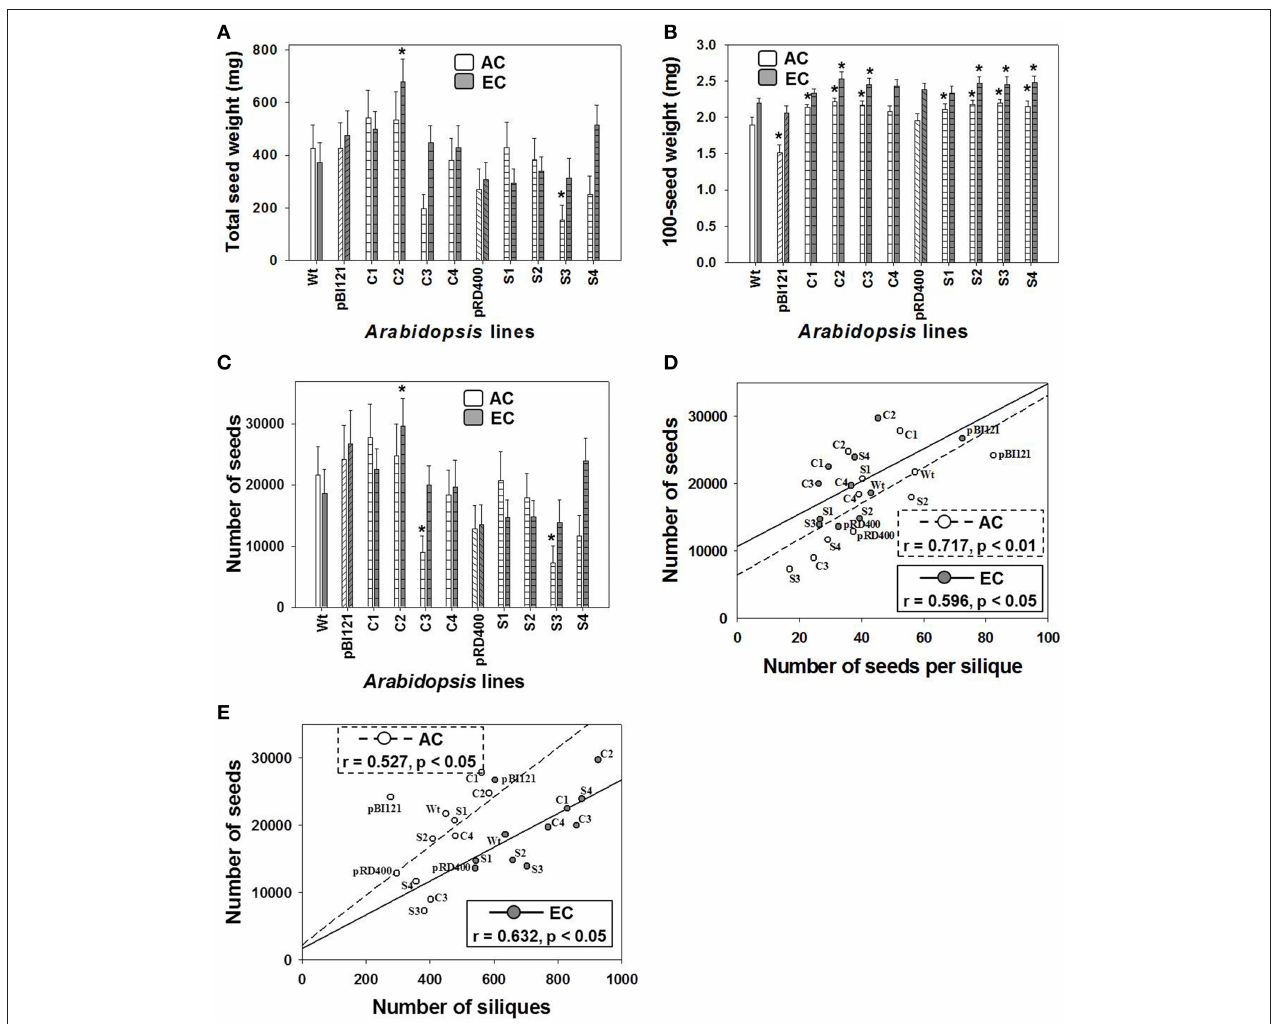
FIGURE 7 | Seed production in Arabidopsis lines grown at either AC or EC. Total seed weight (A) , average weight of 100 seeds (B) , total number of seeds (C) and its correlation with the number of seeds per silique (D) , and the total number of siliques (E) is provided. CO 2 treatments: 380 ppm (AC, white bars or open circles/dashed line), 700 ppm (EC, gray bars or closed circles/solid line). Asterisks ( * ) indicate results significantly different from wild type (WT) at α = 0.05. For (A–C) , values represent the mean ± SE; n = 10 plants per line. For (D,E) , the Pearson correlation coefficients (r), significance level, and the lines of best fit are